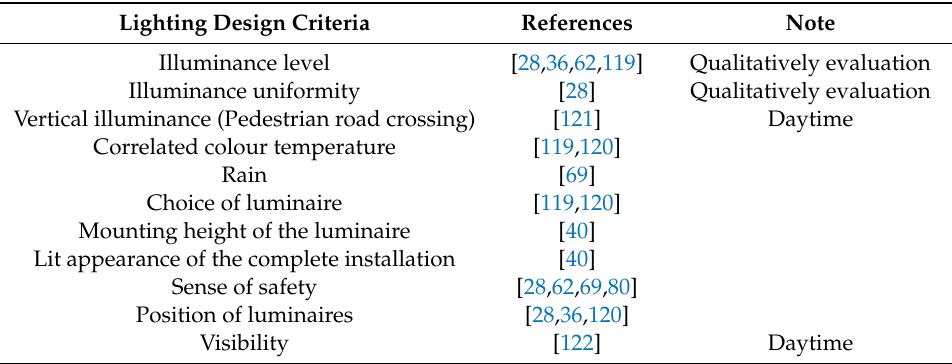
Table 2. List of lighting design criteria analysed using virtual